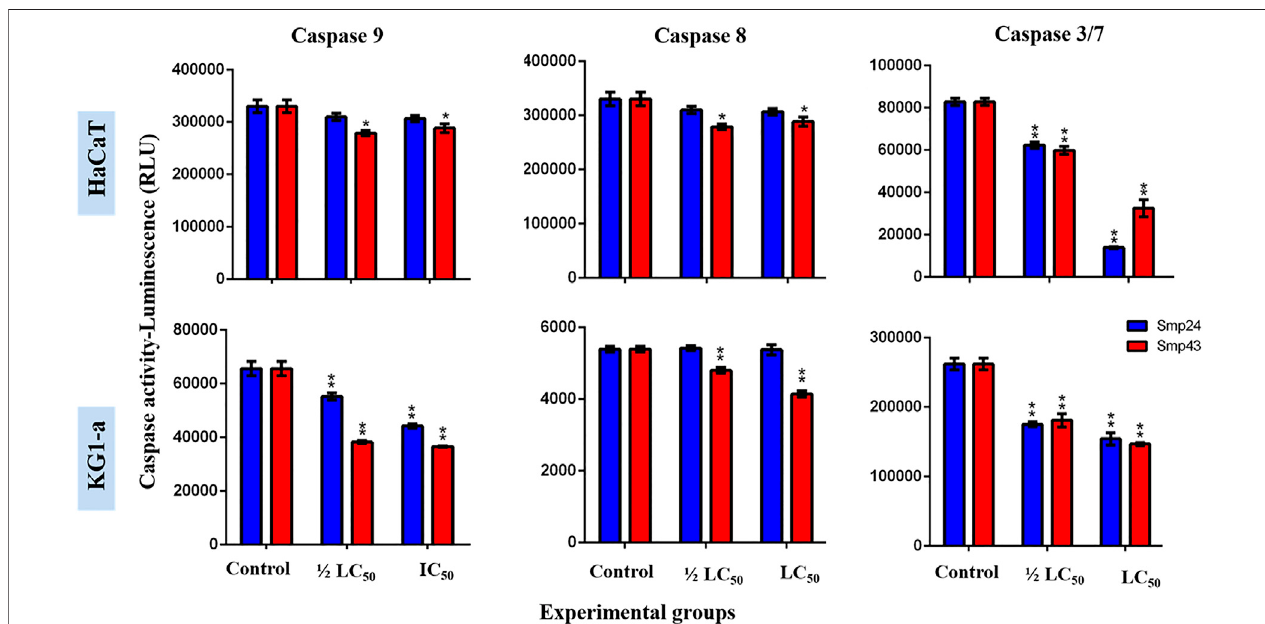
FIGURE4| ChartsshowingtheeffectofSmp24andSmp43(1/2LC 50 andLC 50 )ontheactivityofcaspase8,9and3/7ofrepresentativenon-tumour(HaCaT)and tumour (KG1-a) cell lines. The results showed no signi fi cant increase in caspases activities. The data represented as mean ± SE. The statistical signi fi cance (* p ≤ 0.05, ** p ≤ 0.001) was determined by comparison with the control using student